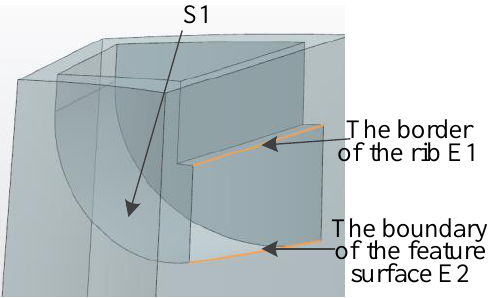
Figure 17. Schematic diagram of characteristic boundary of turning section.